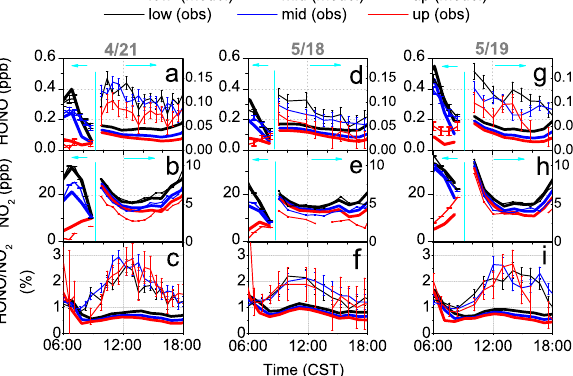
Table 2. Initial concentrations in the model in ppb.